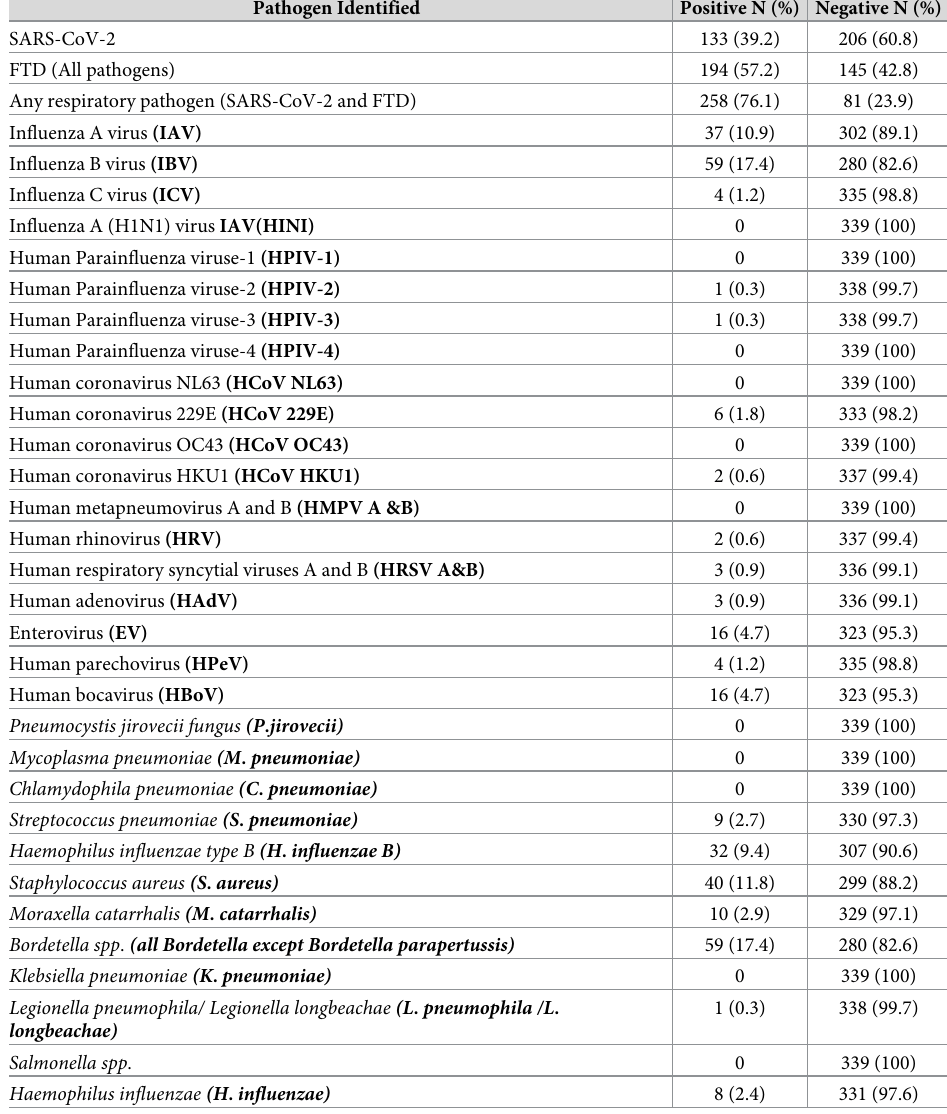
Table 3. Respiratory-pathogen frequencies identified via the fast track diagnostics real-time PCR kit (N =